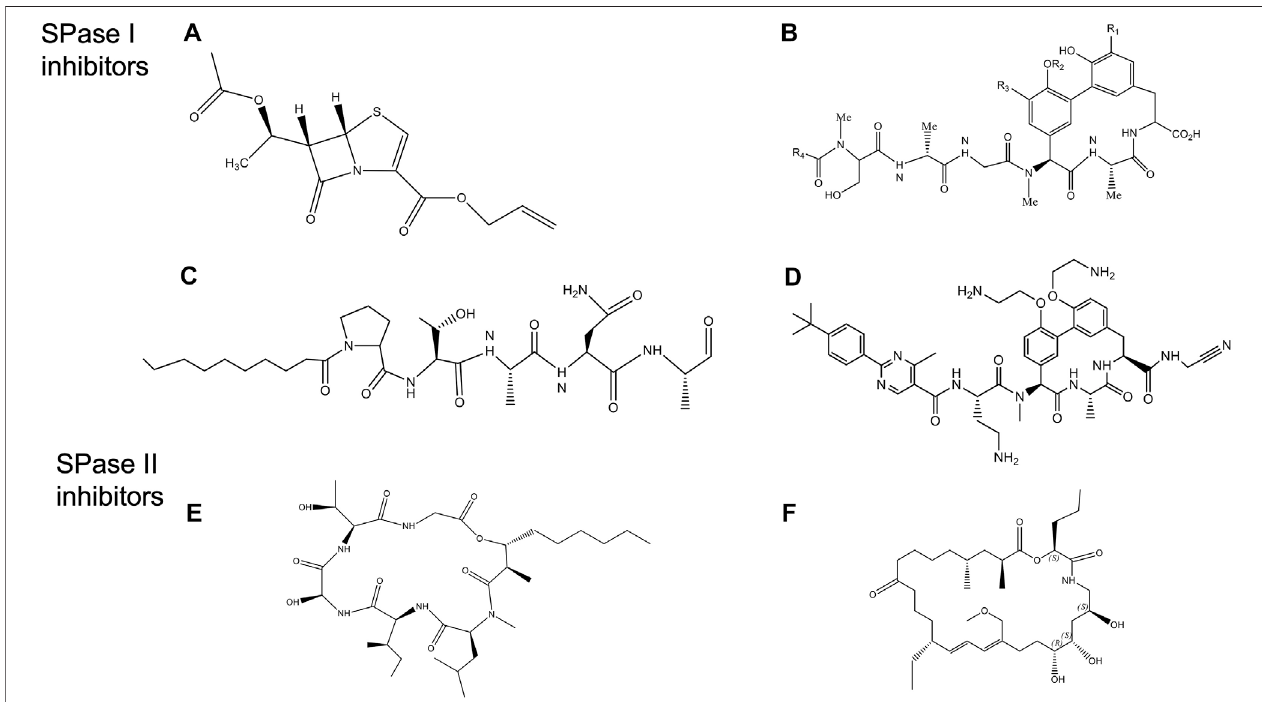
FIGURE10| StructuresofSignalpeptidaseinhibitors(Raoetal.,2014). (A) allyl(5S,6S)-6[(R)-acetoxyethyl]-penem-3-carboxylate. (B) ArylomycinA. (C) Decanoyl PTANA aldehyde. (D) GO775, an optimized arylomycin. (E) Globomycin. (F) Myxovirescin.